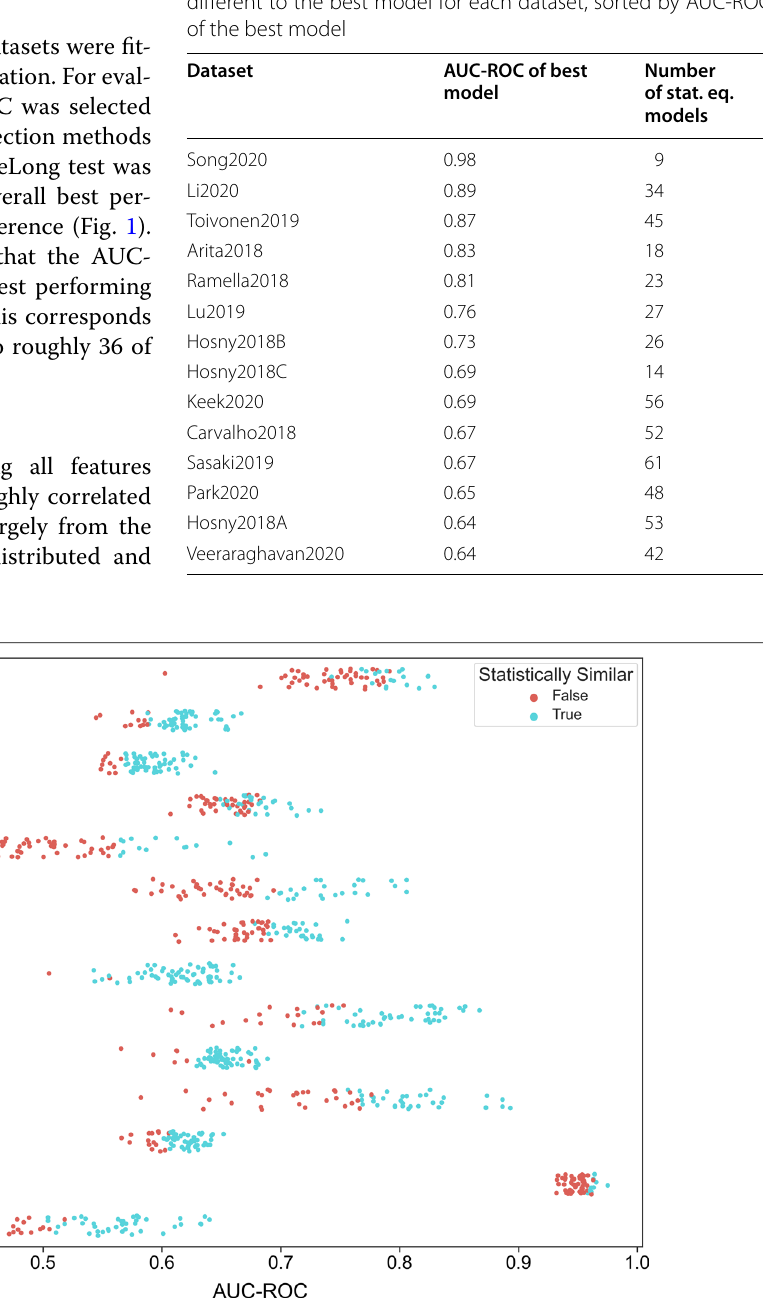
Fig. 1 Graphical overview of the predictive performance of all models. The AUC-ROC of all computed models were plotted for all datasets. Those models that cannot be statistically shown to be different from the best model were marked in cyan color, while those that were worse were marked in orange color